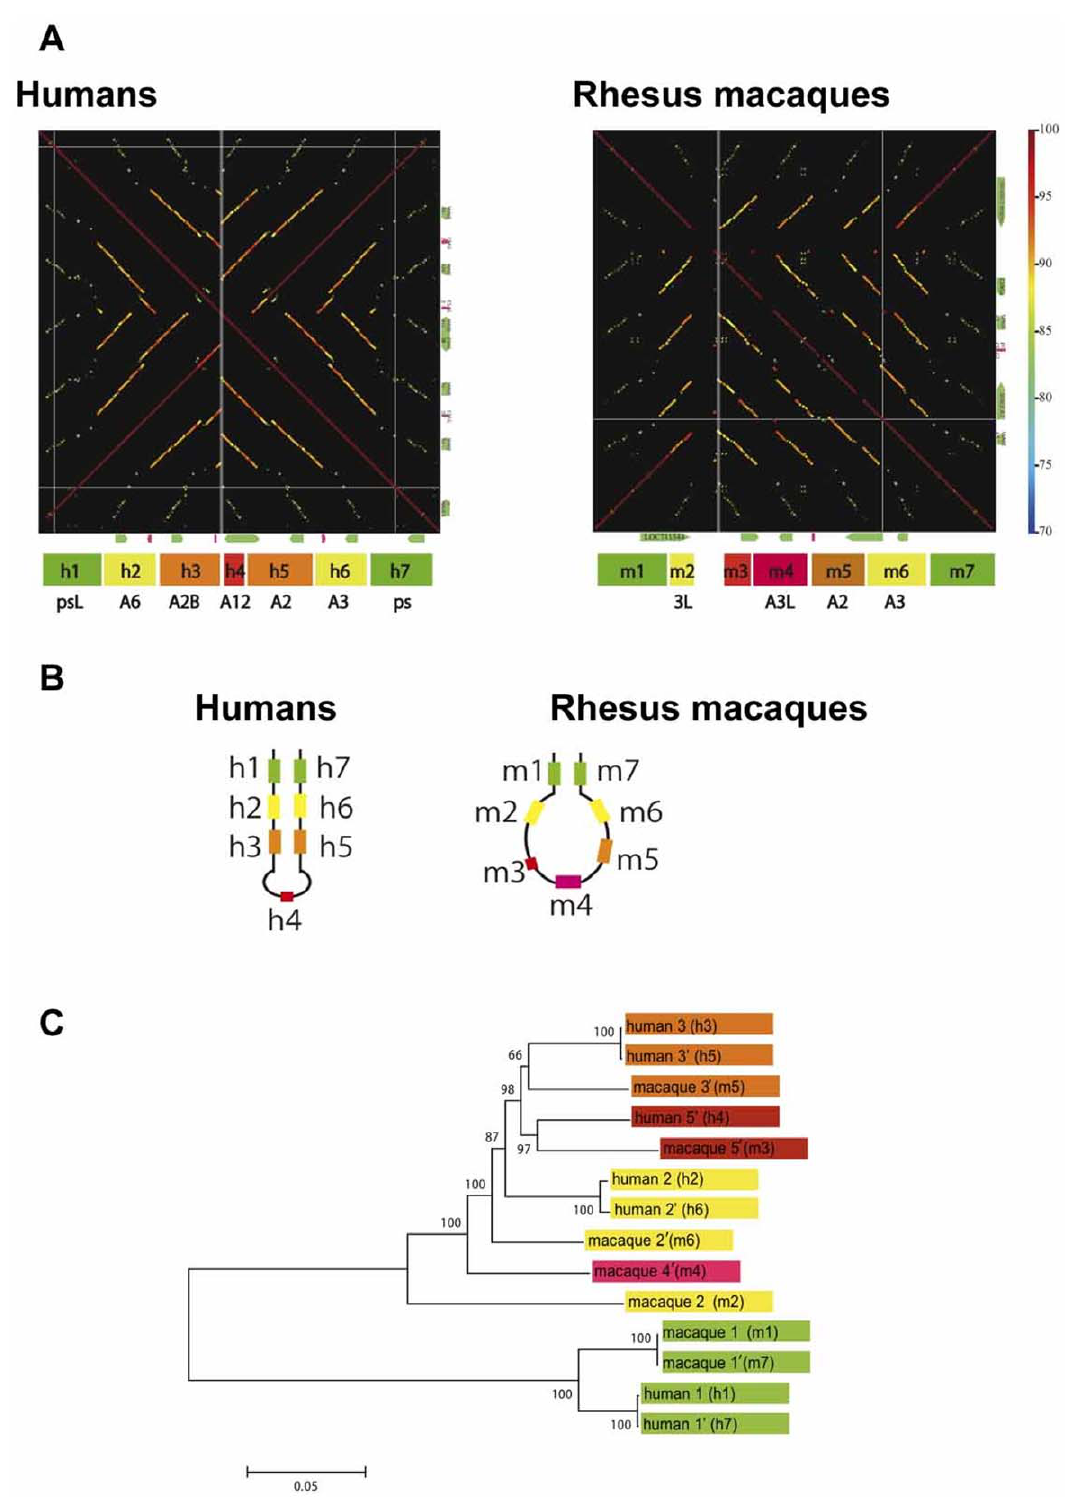
Figure 5. Genomic structures, phylogeny and predicted palindromes in subregion B. ( A ) The diagonal lines from the left top to the right bottom indicates identity within the human (left panel) or the macaque (right panel) sequence. Gaps in the diagonal line in the macaque indicate sequencing gaps. The colored boxes at the bottom of each panel indicate seven duplicated units. The same colored boxes within a species indicate that they are more closely related to each other than to others, whereas those between species indicate putative orthologs. ( B ) Palindromes predicted in subregion B of the human (left) or the macaque (right) sequence. Numbers beside the lines indicate each duplicated unit. ( C ) An NJ tree based on p -distances between duplicated units (2880 bp) is shown. The color-code for OTU is the same as in ( A ) and ( B ).